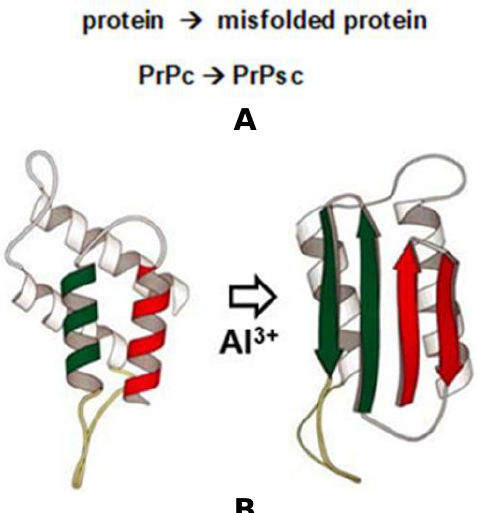
Figure 3. Al 3+ and the prion PrPc to PrPsc transition in neurodegenerative disease-prion disease (PrD) in mammals appears to be caused by a conformational transition from the cellular prion protein’s native conformation (PrPc) into a pathological isoform called “prion protein-scrapie” (PrPsc); multiple prion-associated neurodegenerative disorders are a consequence of protein misfolding, aggregation, and spread; ( A ) graphical representation of the scheme of the structural transition of the prion protein-cellular (PrPc) native form to the prion-scrapie isoform PrPsc; ( B ) model of the structure of the α -helical-enriched cellular prion protein (PrPc; red and green alpha-helices) to the pathological (abnormal) β -pleated sheet-enriched prion protein (PrPsc; red and green anti- parallel arrows); published evidence indicates that trivalent aluminum (Al 3+ ; Al(III)) exacerbates both amyloid formation into insoluble aggregates from naturally-occurring A β peptides and increases the rate of the onset of AD-type symptomology in transgenic murine models of AD (TgAD); AD is a complex neurological disorder and unique in that it may represent a ‘double prion’ disorder involving both aggregated tau proteins (as a tauopathy) and A β peptides (as an amyloidopathy) [34–38]; preliminary monoclonal PrPsc antibody-based evidence further suggests that trivalent aluminum (Al 3 + ; Al(III)) also promotes the misfolding of PrPc into the PrPsc isoform (see manuscript text); structures adapted from references